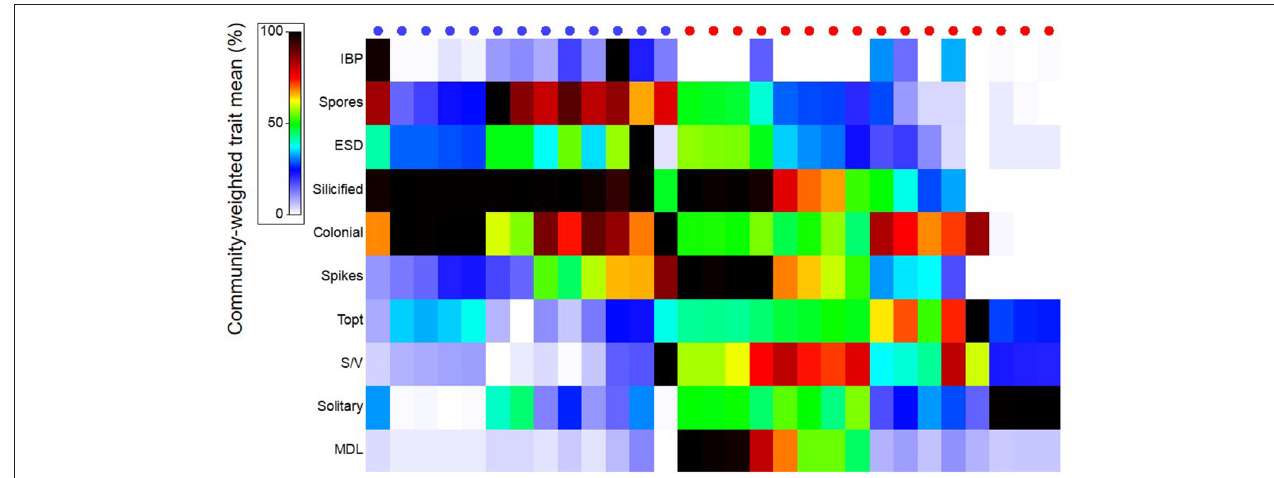
FIGURE 6 | Community-weighted trait mean of diatom species (%) found in Arctic- (blue) and Atlantic (red) influenced stations (circles at the top). Trait abbreviations are explained in Figure 3 .